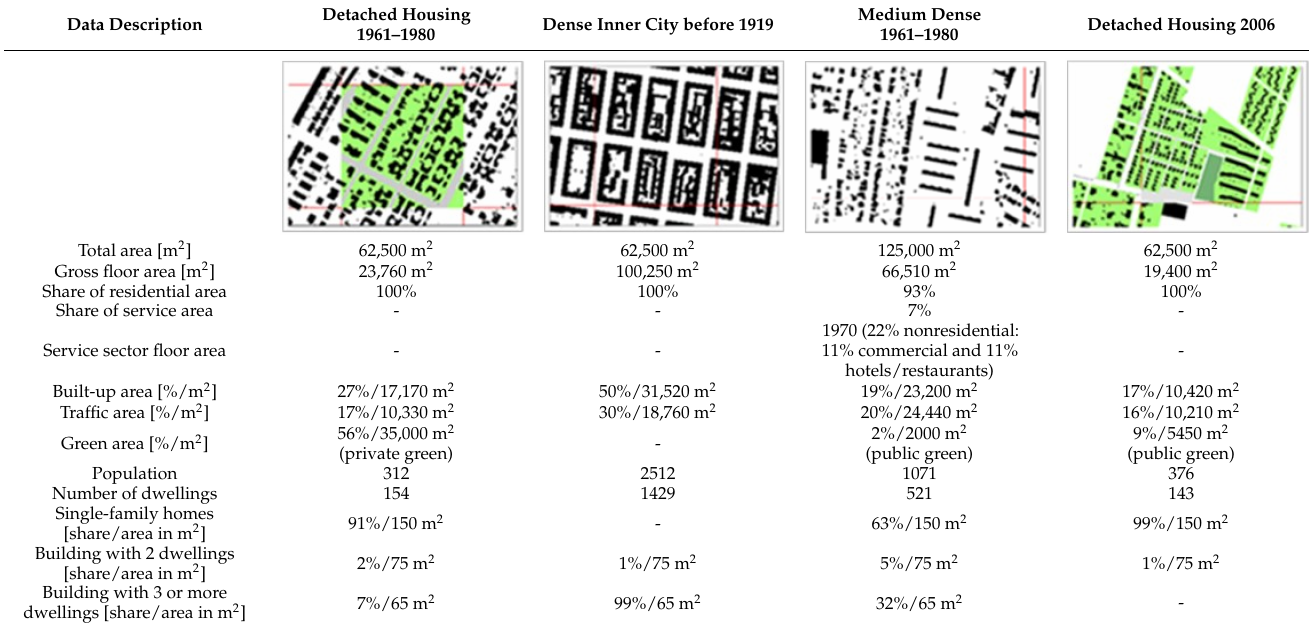
Table 1. Base data of the selected urban